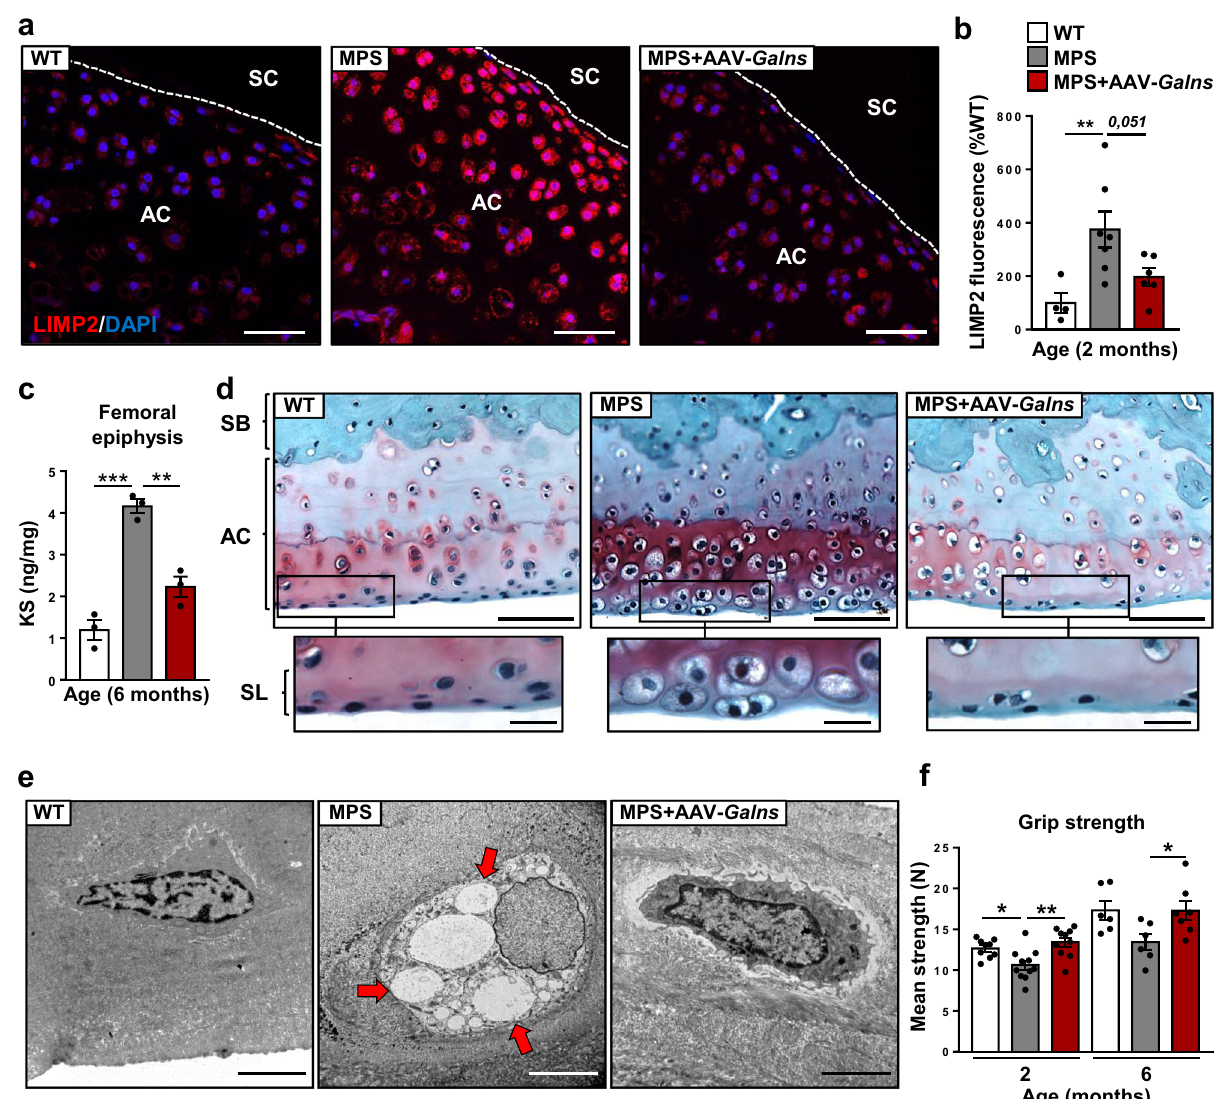
Fig. 5 Treatment with Galns -encoding vectors of articular cartilage pathology. MPSIVA rats were treated intravascularly with 6.67 × 10 13 vg/kg AAV9- Galns vectors at 4 weeks of age. a LIMP2 immunohistochemical analysis of humeral articular cartilage sections from 2-months-old WT, untreated and AAV9- Galns -treated MPSIVA rats. Articular chondrocytes from MPSIVA rats presented severe lysosomal distension that was markedly reduced after AAV9- Galns treatment. Scale bars: 50 µ m. AC articular cartilage, SC synovial cavity. b Quanti fi cation of LIMP2 mean fl uorescence in articular cartilage of 2-months-old WT ( n = 4), untreated ( n = 7) and AAV9- Galns -treated ( n = 6) MPSIVA rats. c KS content in the distal femoral epiphysis of 6-months-old WT, untreated and AAV9- Galns -treated MPSIVA rats ( n = 3 animals/group). d Safranin O staining of histological sections of humerus articular cartilage of 6-months-old WT, untreated and AAV9- Galns -treated MPSIVA rats ( n = 3 animals/group). Scale bars, 50 µ m; insets, 20 µ m. SB subchondral bone, SL super fi cial layer. e Ultrastructural analysis of SL from tibial articular cartilage of 6-months-old WT, untreated and AAV9- Galns -treated MPSIVA rats. Large electrolucent vacuoles (arrows) were detected in chondrocytes of untreated MPSIVA rats, that were absent after AAV9- Galns treatment. n = 2 animals/ group. Scale bars, 5 µ m. f Grip strength analysis of 2- and 6-months-old WT ( n = 9, 6, respectively), untreated ( n = 11, 6, respectively) and AAV9- Galns- treated ( n = 10, 7, respectively) MPSIVA rats. All results are shown as mean ± SEM and P -values of one-way Anova test are indicated (95% con fi dence interval). * P < 0.05, ** P < 0.01, and *** P < 0.001 vs. untreated M P SIVA rats. Source data are provided as a Source Data fi of 4 years of age and older are eligible in the Phase I/II clinical trial using the liver-directed AAV8-TGB-h ARSB gene therapy ( ClinicalTrials.gov Identi fi er: NCT03173521 ). Similarly, to prevent loss of transgene expression because of hepatocyte cell division, in all clinical trials performed up to date using liver-directed AAV- mediated gene therapy approaches to treat rare diseases, patients are older than 4 years 70 . In this regard, i.e., for Crigler Najjar, patients must be aged ≥ 10 years (ClinicalTrials.gov Identi fi er: NCT03466463), and for Hemophilia (ClinicalTrials.gov Identi fi er: NCT03001830) and Pompe disease (ClinicalTrials.gov Identi fi er: NCT04093349) the